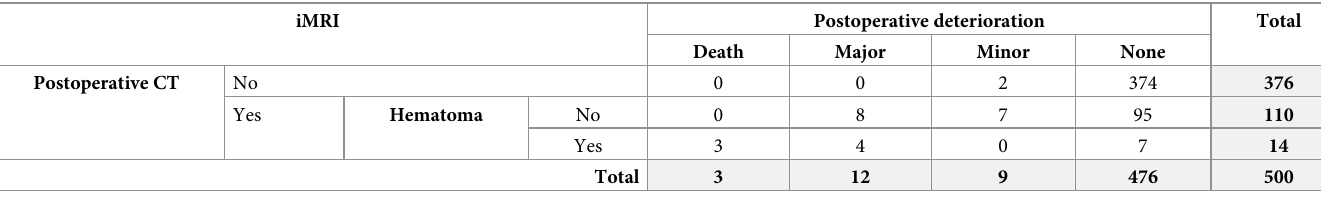
Table 3. Postoperative imaging, hematoma and neurologic status in the iMRI